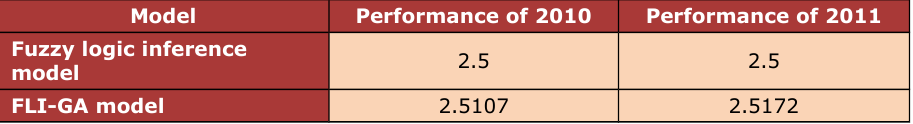
Table 4. Simulation results comparison between two